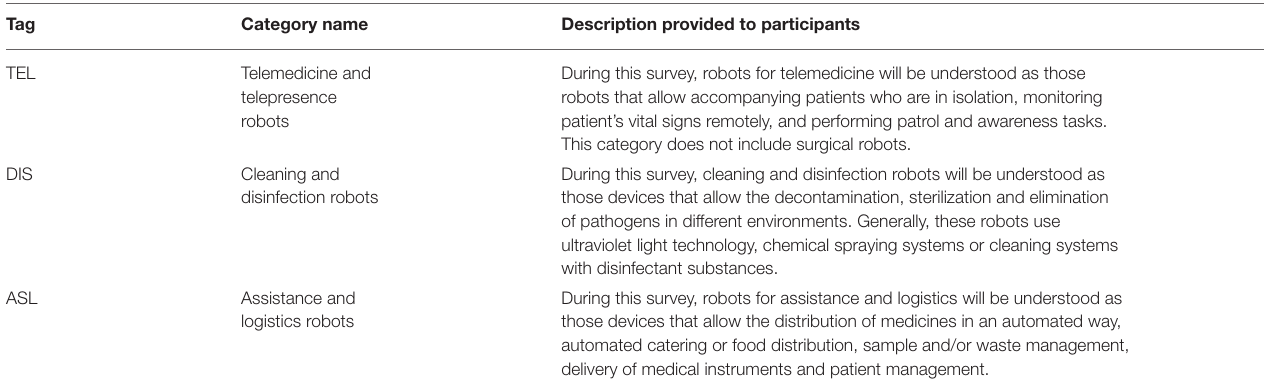
TABLE 5 | Brief description of the different robot categories that were used in the